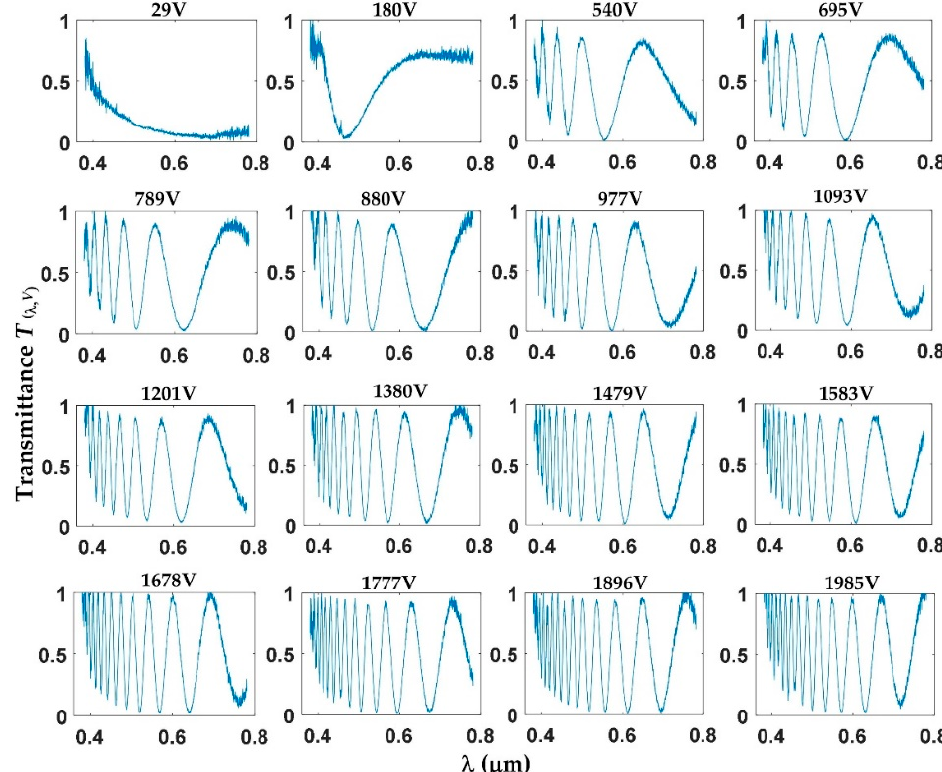
Figure 4. Calibration of spectral transmittance coding under different driving voltages.